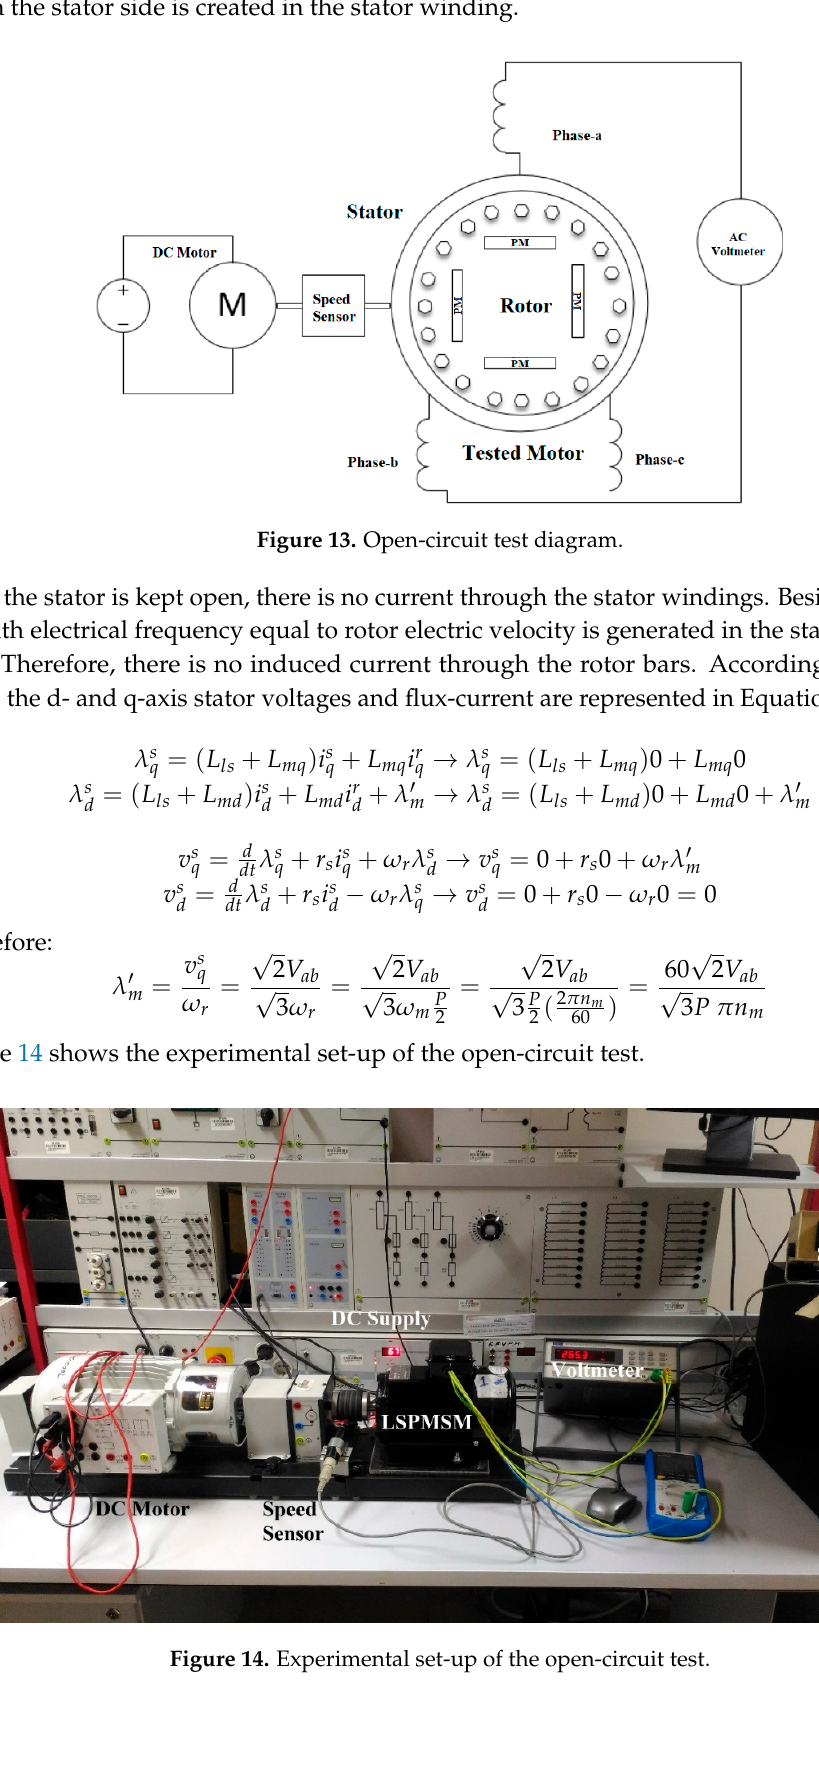
Figure 14. Experimental set-up of the open-circuit test.